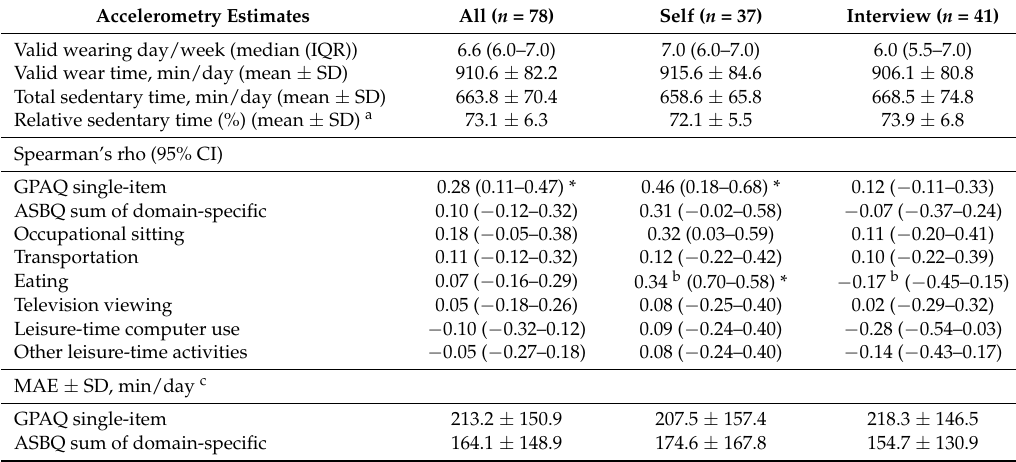
Table 1. Accelerometry-derived sedentary time estimates using 150 counts per minute (CPM) and convergent validity of the Global Physical Activity Questionnaire (GPAQ) and the Adult Sedentary Behaviour Questionnaire